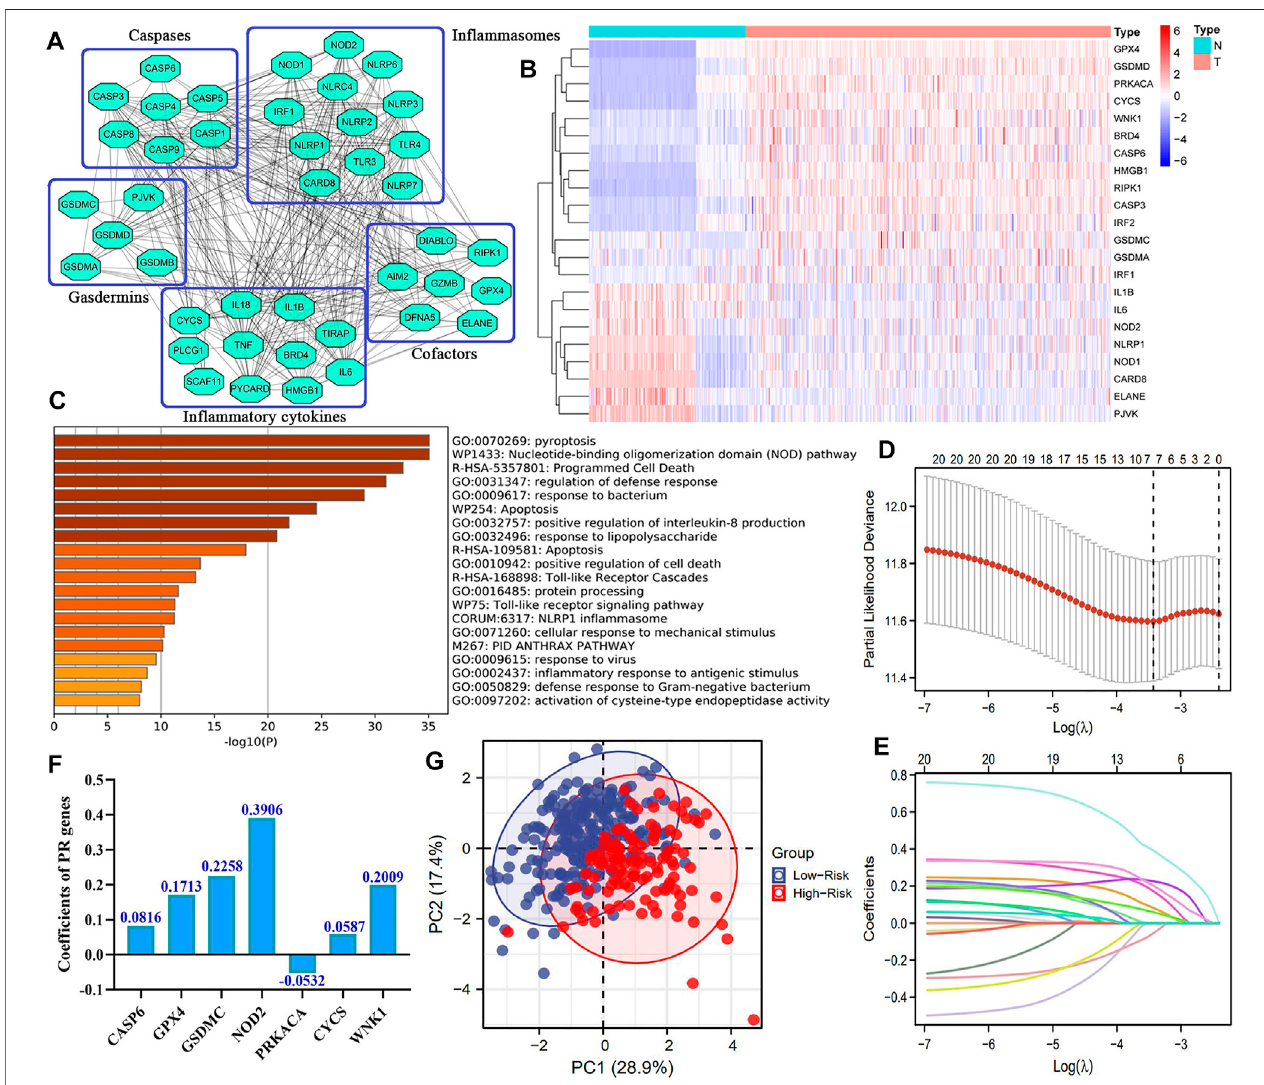
FIGURE2| NovelPRrisksignature. (A) ThePPInetworkof45corepyroptosisregulatorygenes. (B) TheheatmapofpyroptosisDEGs. (C) Thebiologicalfunctions of 45 PRGs (D – E) The process of Lasso regression analysis (F) The coef fi cients of each PRG in PR risk signature. (G) The PCA plots. PR, pyroptosis-related; PPI, protein – protein interaction; DEGs, differentially expressed genes; PRGs, pyroptosis-related genes; PCA, principal component analysis.